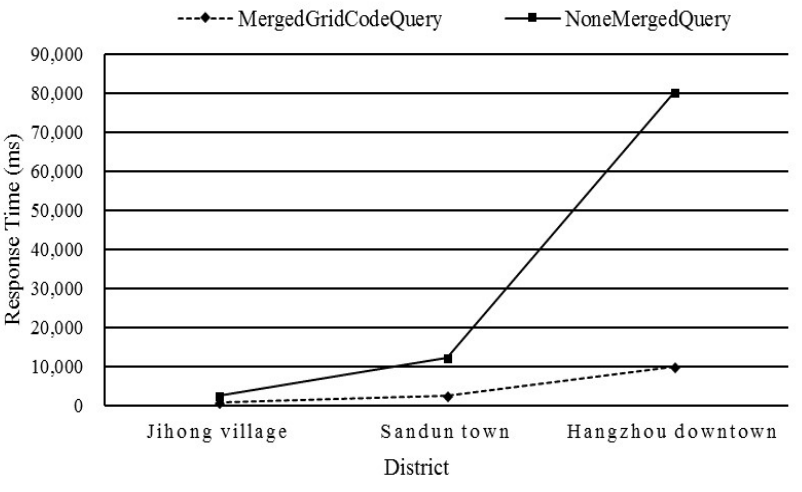
Figure 19. Intersection query efficiency with the optimized strategy on merging grid cell codes.